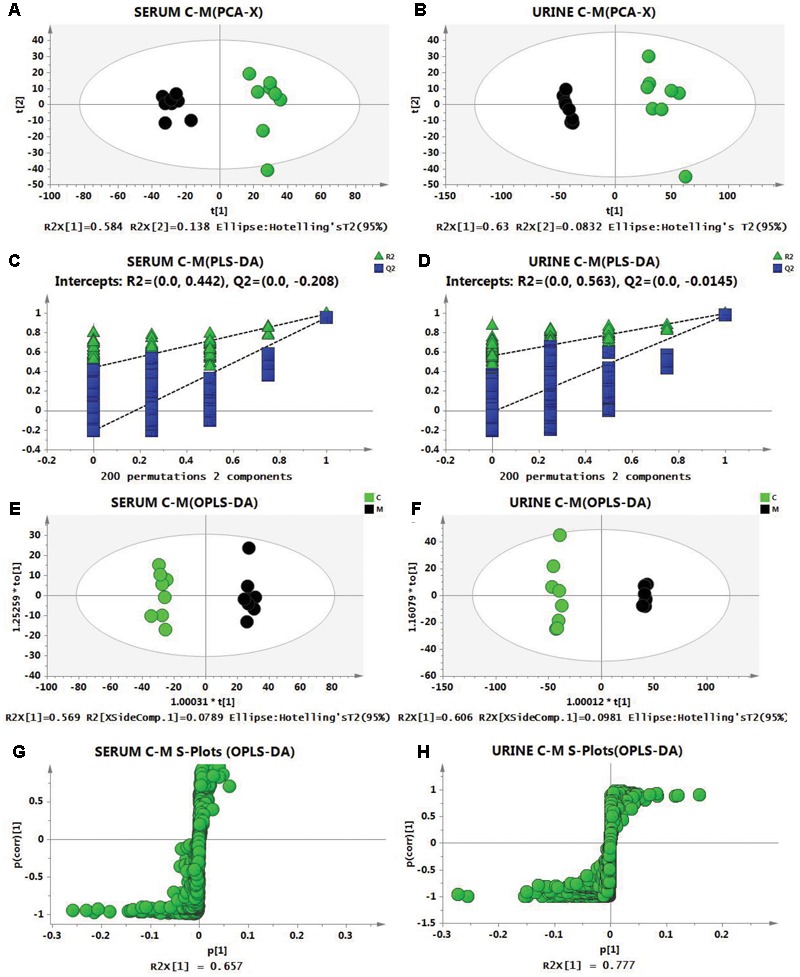
Score plots from the PCA model of the control group (green) vs. the model group (black) for (A) serum and (B) urine. Two hundred permutations of the PLS-DA model for serum (C) and urine (D). R2 (green triangle); Q2 (blue square). Score plots form the OPLS-DA model of the control group (C, green) vs. the model group (M, black) for serum (E) and urine (F). S-Plots from the OPLS-DA model for serum (G) and urine (H).